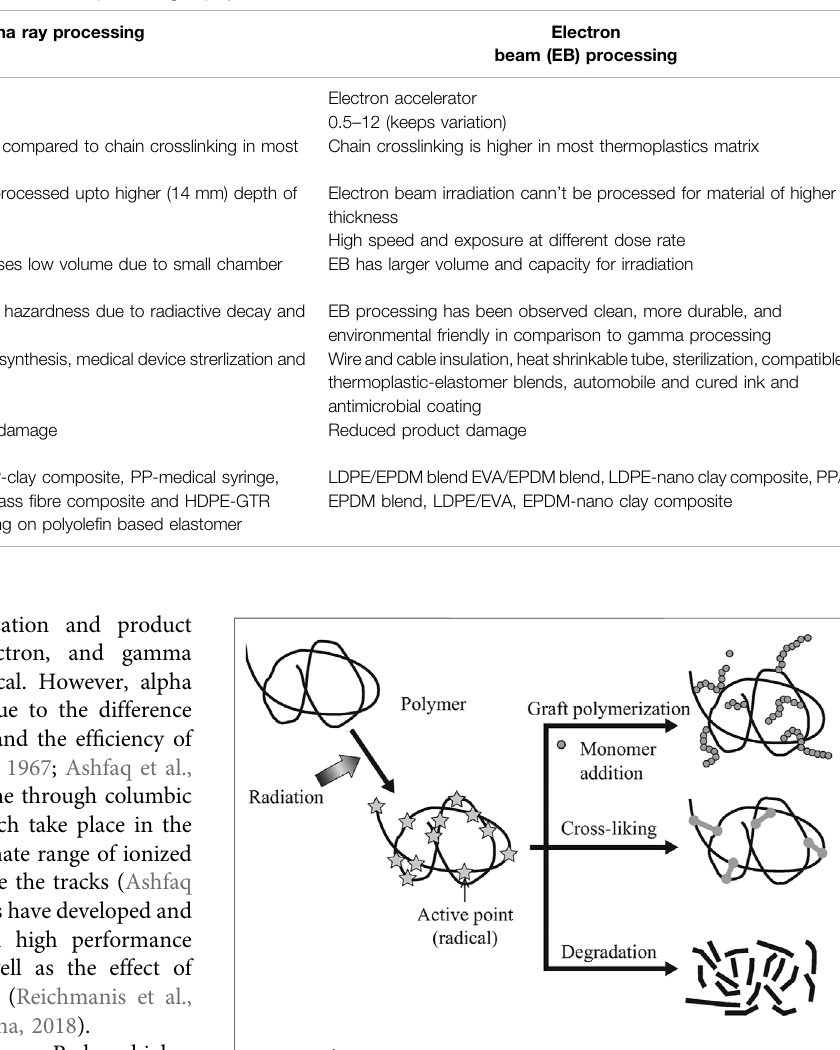
FIGURE 1 | The effect of high energy (gamma) irradiation on polymers in different manner (Tamada and Maekawa,